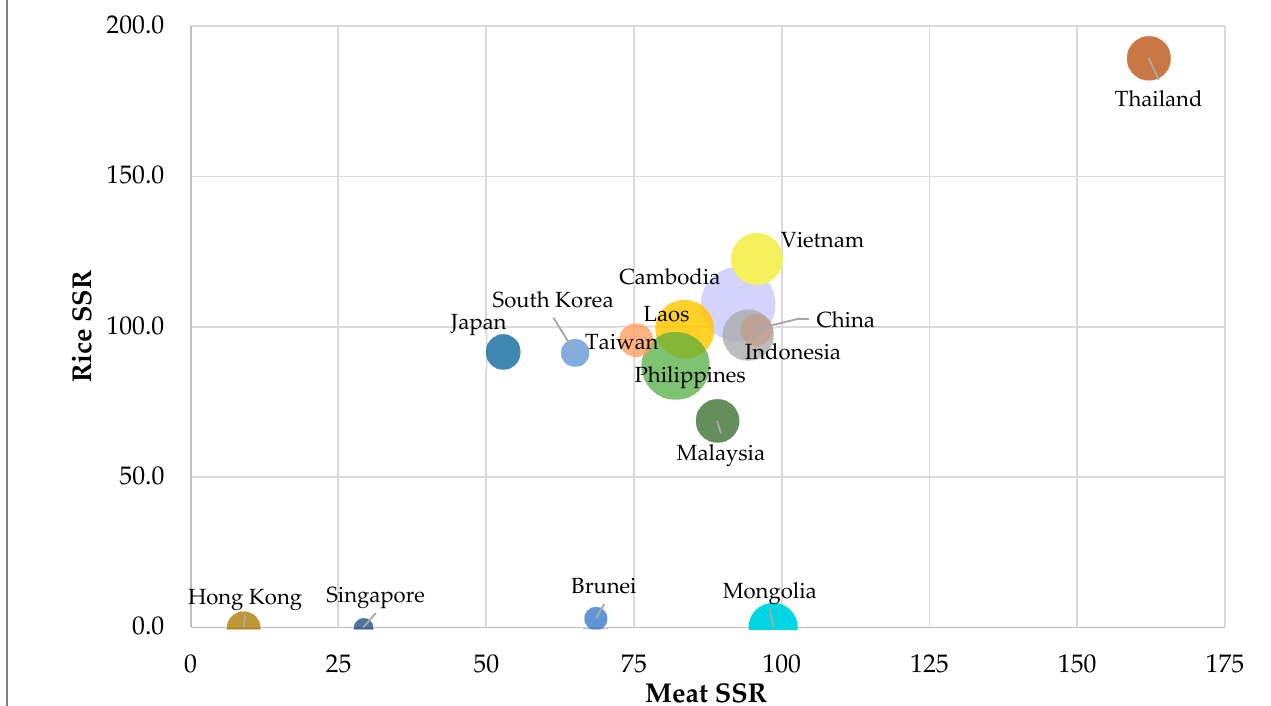
Figure 1. Share of expenditure on food in total GDP for East and Southeast Asian economies in 2017 (Percent, GDP = 100%) (Source: data retrieved and adapted from [33]).